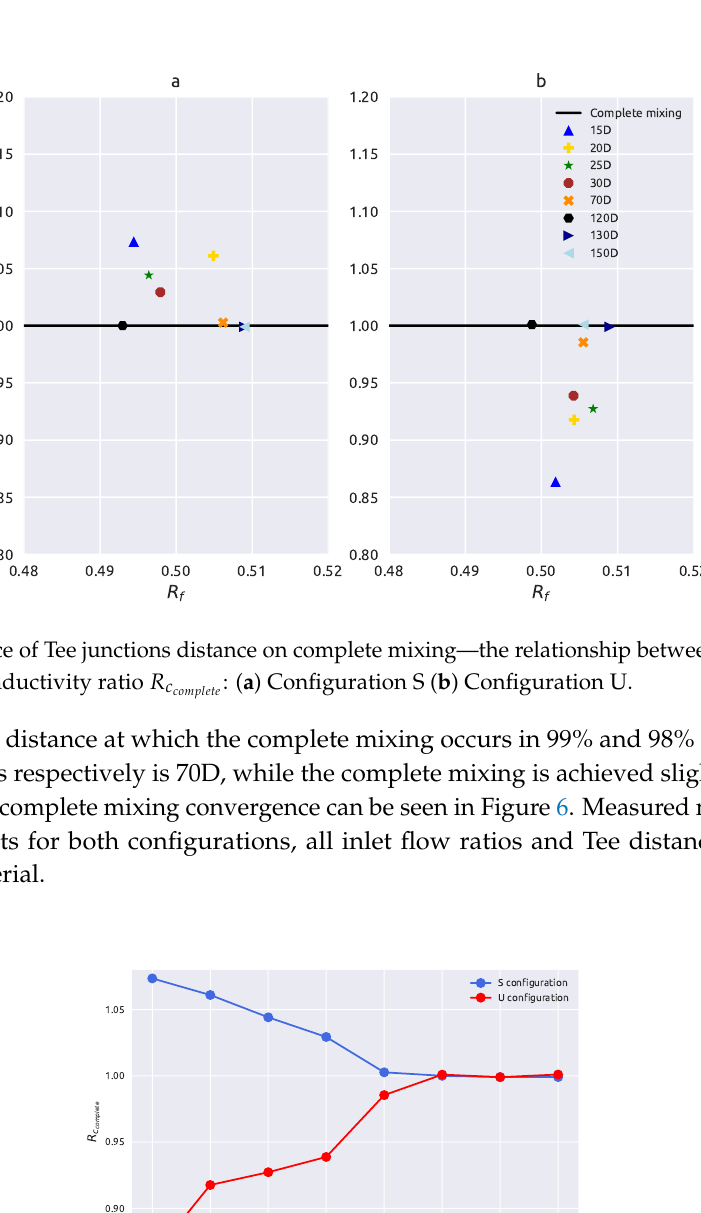
and Tee-junction complete